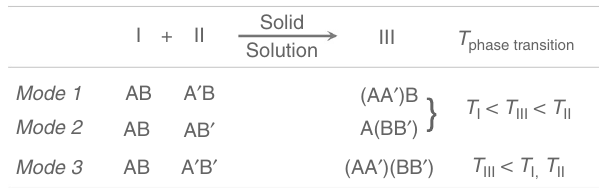
Fig. 1 Three mixing modes for the formation of phase-changeable CP solid solutions. A single-component substitution method ( Modes 1 and 2 ) and a synchronous dual mixing strategy ( Mode 3 ).